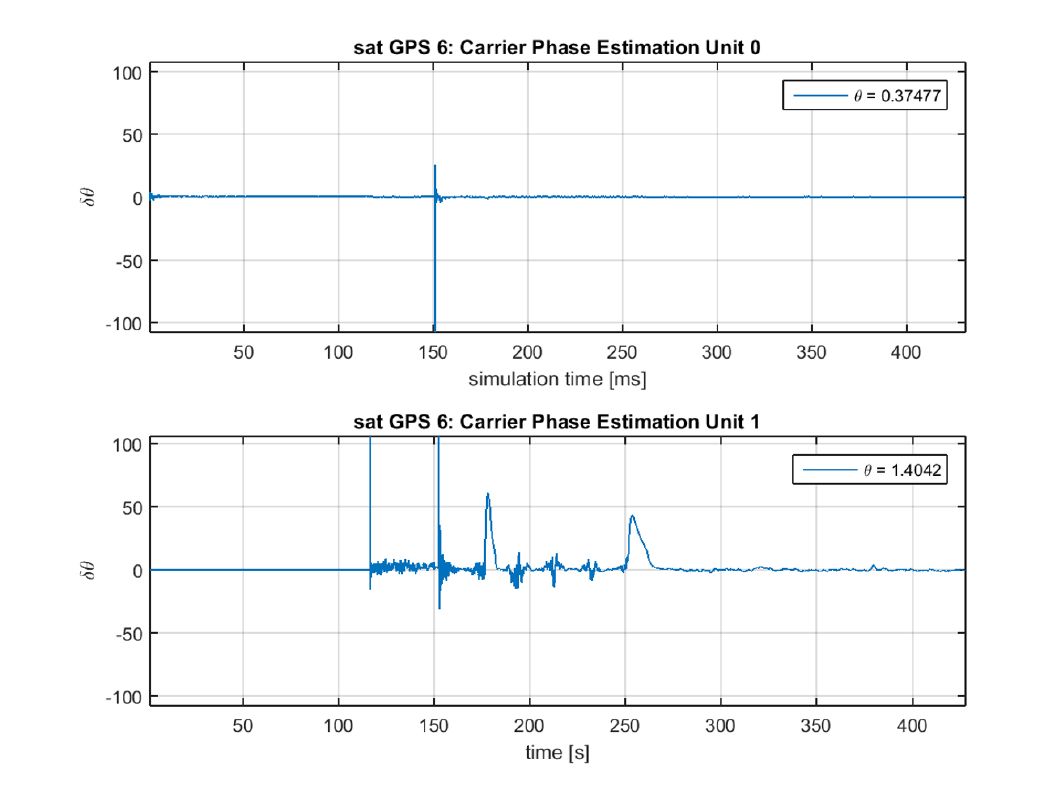
Figure 12. Phase estimation for Unit0 ( top ) and Unit1 ( bottom ) for TEXBAT